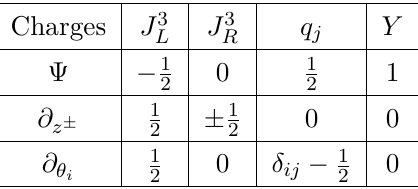
Table 1 . Angular momenta and charges of the BPS superfield and